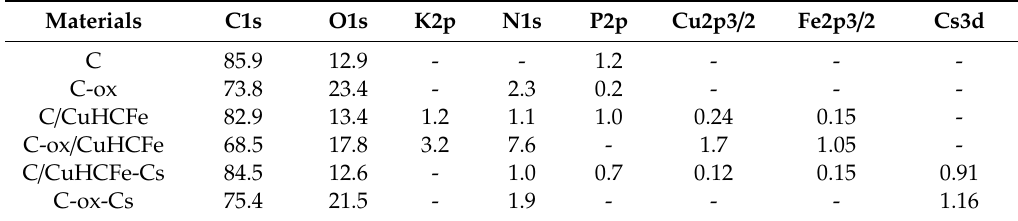
Table 2. XPS atomic quantification (at.%) of carbon supports and carbon / CuHCFe materials before and after the Cs